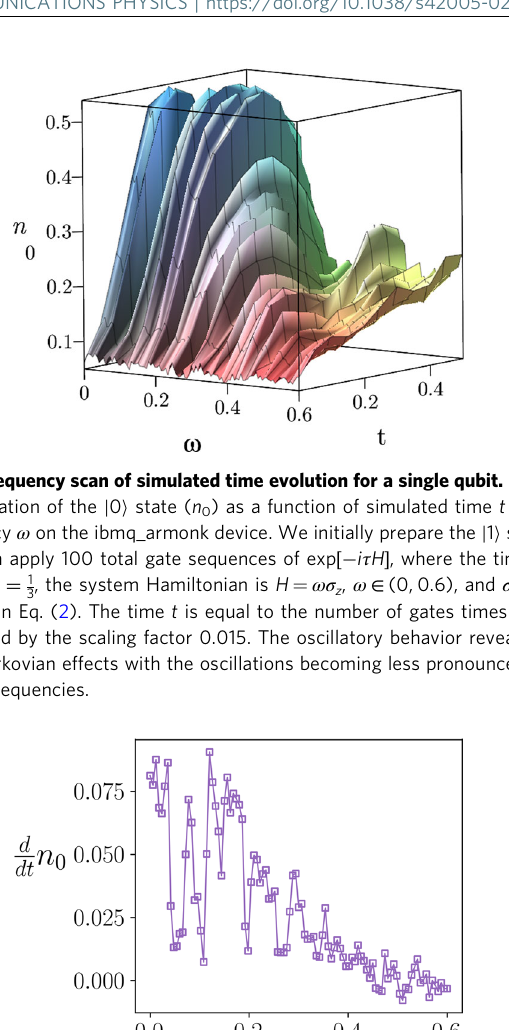
Fig. 2 Rate of population change with respect to simulated time for different frequencies with a single-qubit system. Approximate rate of ground-state populations changes d dt n 0 as a function of frequency ω evaluated after the fi rst time step, which is proportional to the spectral density. The data is taken from the scan in Fig. 1 from ibmq_armonk.